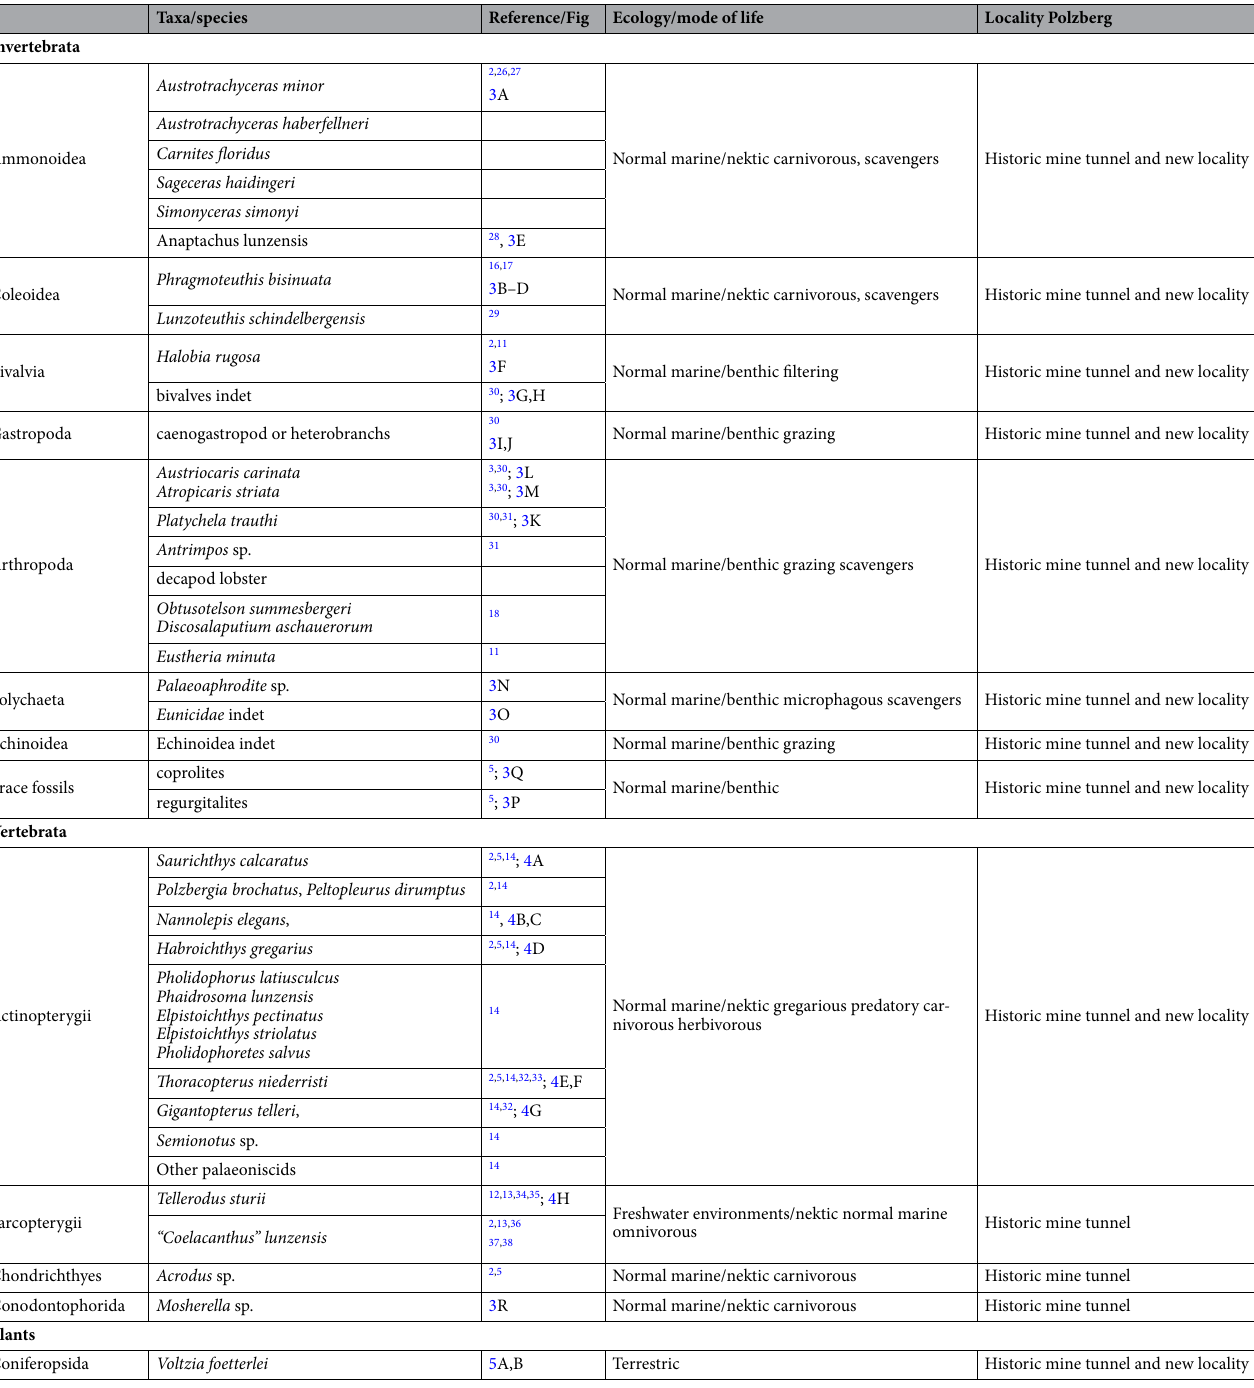
“mass-mortality” of Austrotrachyceras , (11) nearly ’monospecific’ faunal spectrum caused by dominance of one element and (12) in situ anaptychi. The above features characterize the shales and the incorporated palaeobiota of the Polzberg Konservat-Lager- stätte , deposited during the Carnian Pluvial Episode 52 or Carnian Wet Intermezzo 53 . The sequence points to the